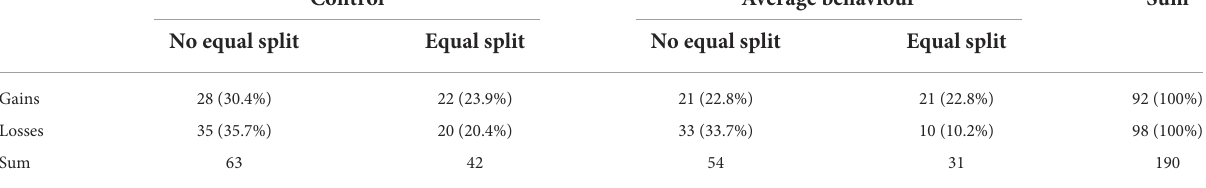
TABLE 2 Frequencies of equal